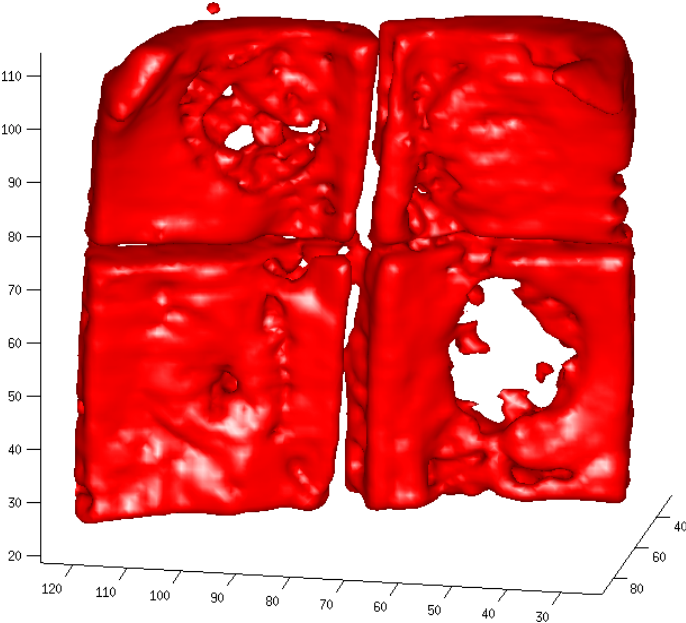
Figure 6. The calvaria lateral view of computerized tomography.